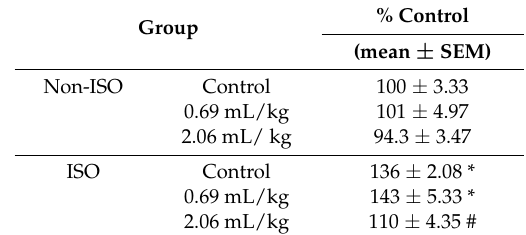
Table 4. Effects of SOD-Like Supreme treatment on plasma AST activity in mice with/without ISO challenge.